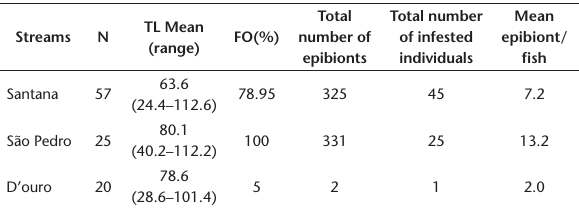
Table 1. Number of examined fish, size range and occurrences of epibiont in the three streams from Atlantic forest in Southeastern Brazil. (N) Number of fishes, (FO) frequency of occurrence, (TL) total length (in